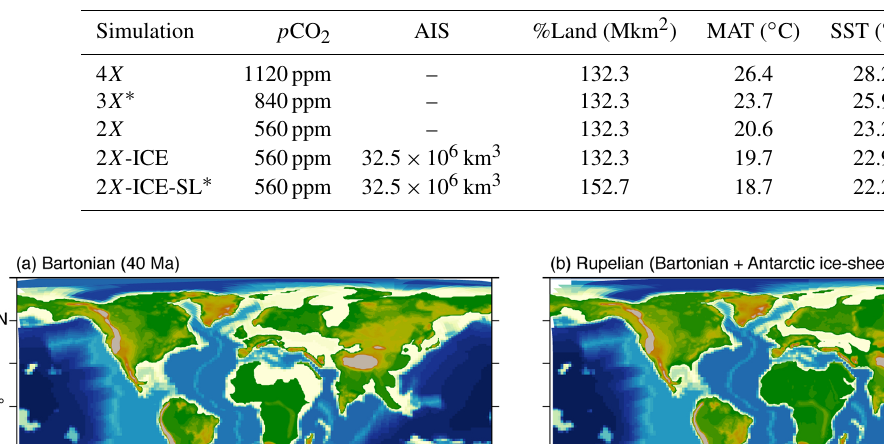
Table 1. Experimental design. Abbreviations: AIS – Antarctic ice-sheet volume (Ladant et al., 2014b); %Land – total land surface (millions of square kilometers – 10 6 km 2 ); MAT – mean annual global 2m air temperature ( ◦ C); SST – sea surface temperature ( ◦ C). Simulations with an asterisk constitute realistic middle Eocene (Lutetian/Bartonian) and early Oligocene (Rupelian) scenarios; others are either sensitivity experiments (2 X , 2 X -ICE) or use the high value of the p CO 2 range estimated for the time interval (4 X ).